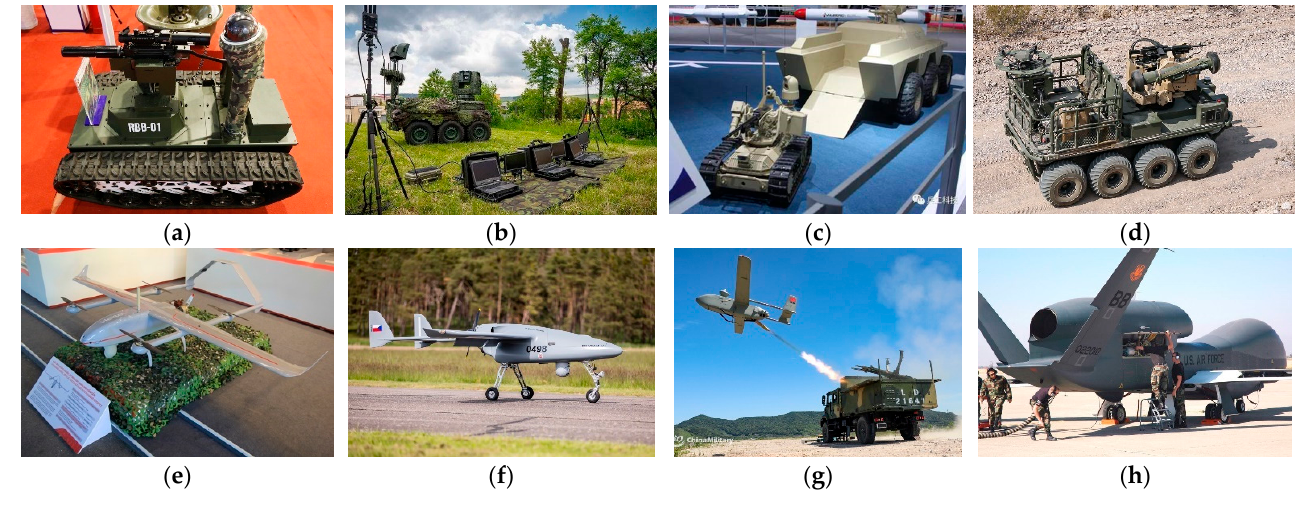
Figure 1. UVs used in different militaries: ( a ) Vietnamese combat UGV [11]; ( b ) Reconnaissance UGV-PzV in Czech Army [12]; ( c ) Chinese combat UGV Ruizhao I and Ruizhao II [13]; ( d ) NATO UGV General Dynamics MUTT [14]; ( e ) Vietnamese UAV Shikra [15]; ( f ) Primoco UAV in Czech Air Force [16]; ( g ) Chinese UAV in PLA 71st Group Army [17]; ( h ) US RQ-4 Global Hawk [18]. Table 1. NATO UAS Classification Guide [10,19,20].